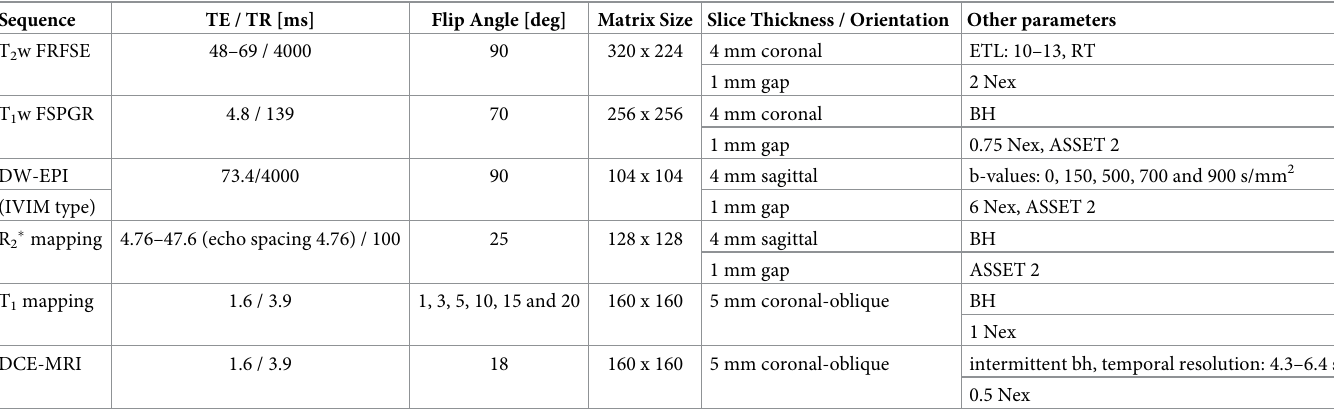
Table 1. Imaging